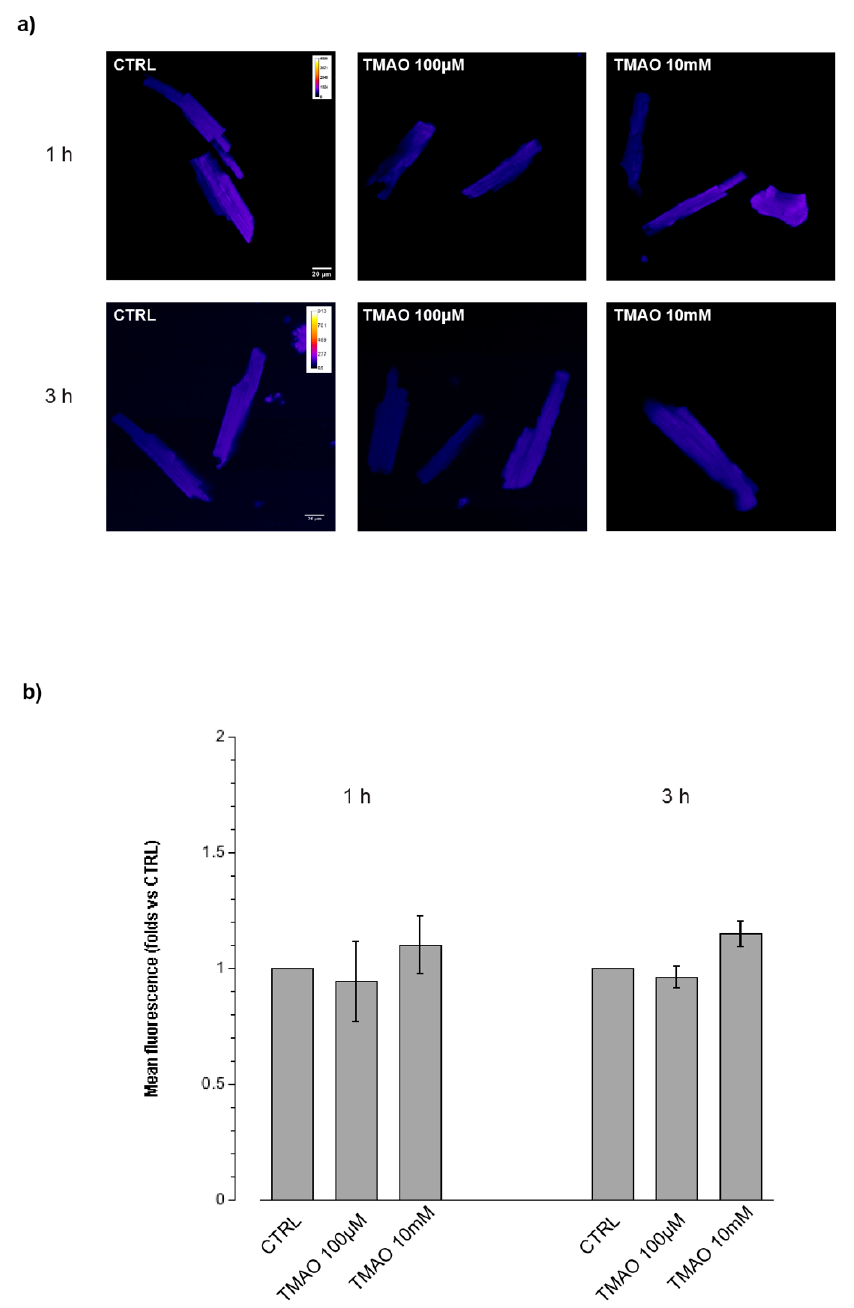
Figure 3. ROS production after 1 h and 3 h of treatment. ( a ) Confocal microscopy images of cells treated with TMAO 100 µ M and TMAO 10 mM for 1 h and 3 h and labeled with the DCF-DA probe (60 × magnification). ( b ) Bar graph showing mean fluorescence after 1 h and 3 h of treatment, no variations or ROS produced are detectable (refer to the main text for numerical values).